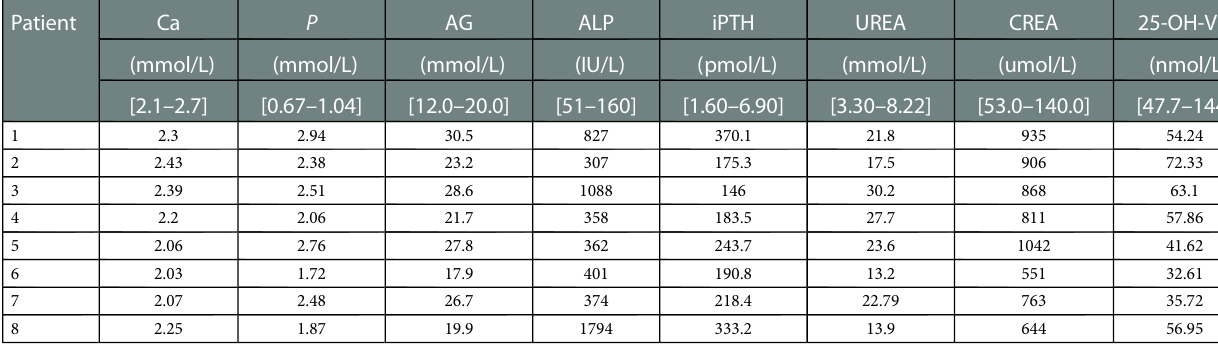
TABLE 2 Summary of the laboratory fi ndings for the patients recruited to the study. Patient